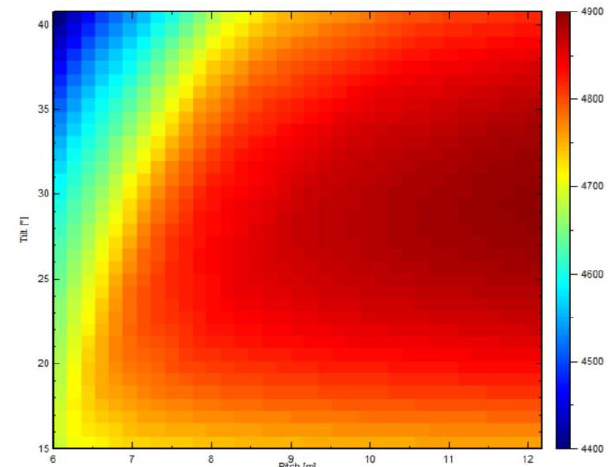
Figure 5. Sub-array grid injected energy (MWh) as a function of pitch and tilt; landscape; central inverter.